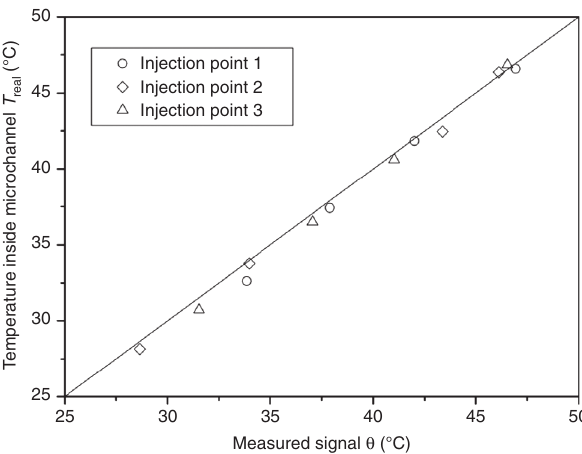
Figure 10 Calibration of the camera signal to the temperature measured by thermocouples at three injection points.